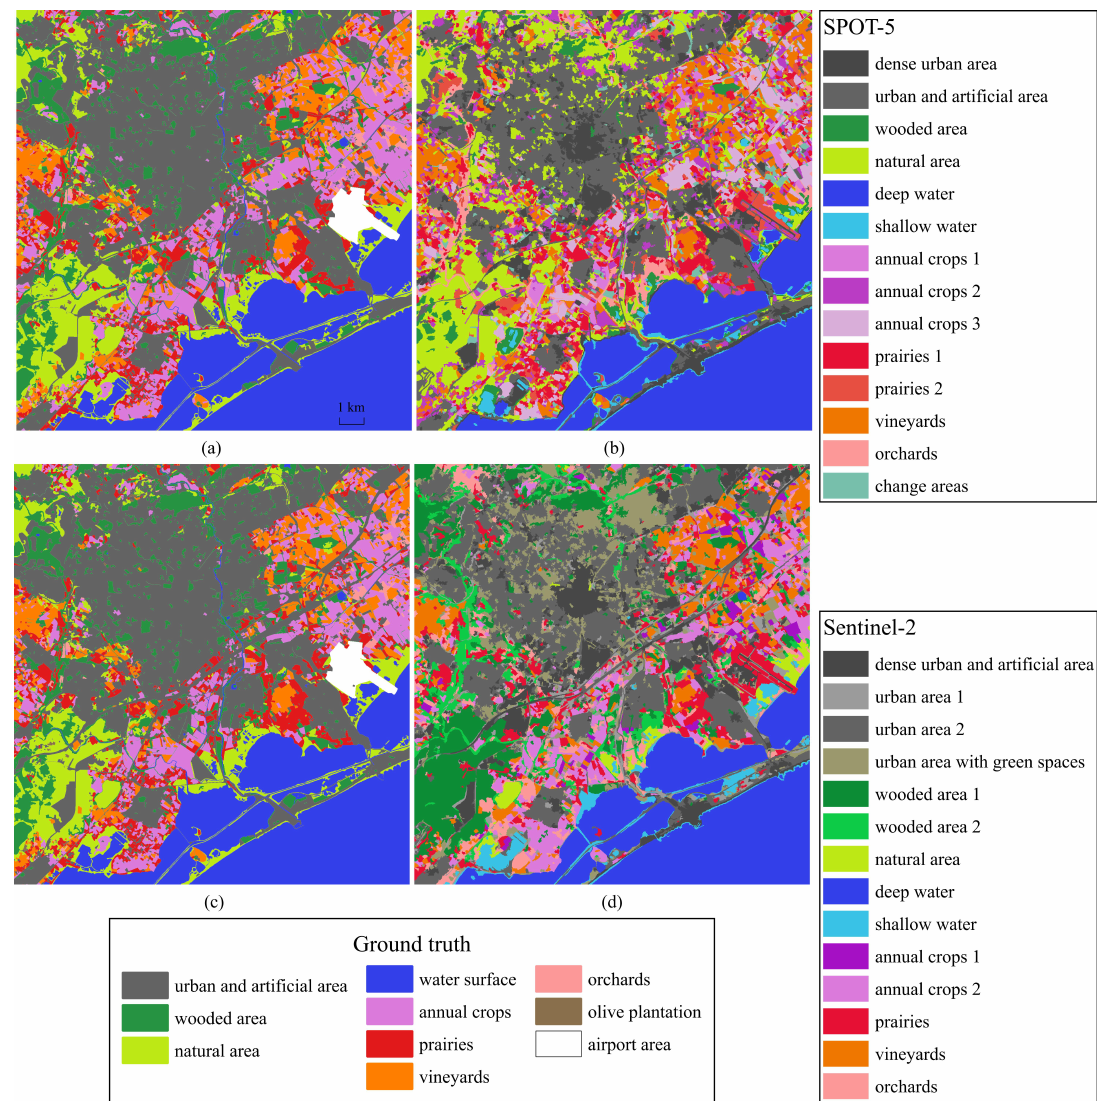
Figure 5. Clustering results for our proposed pipeline. ( a ) GT for 2008 year, ( b ) results for the SPOT-5 dataset, ( c ) GT for 2017 year, ( d ) results for the Sentinel-2